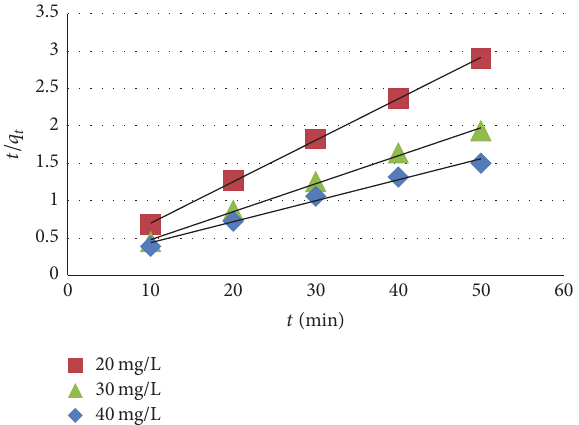
Figure 14: Pseudo-second-order kinetic plot for adsorption of AY on DNPH- 𝛾 -alumina nanoparticles at different initial concentra- tions.